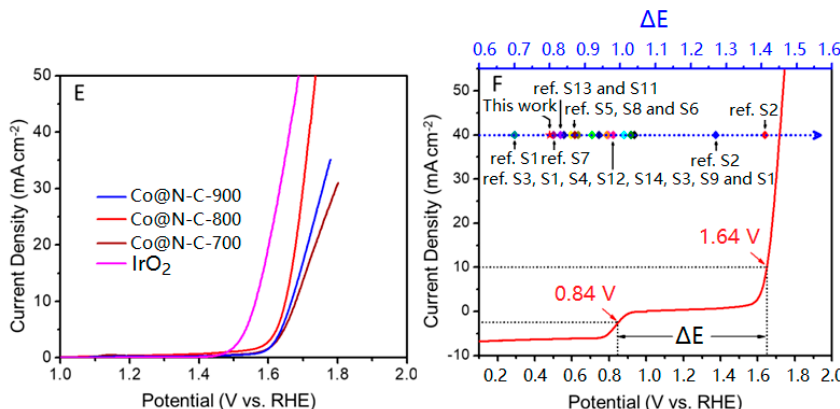
Figure 6. ORR and oxygen evolution reaction (OER) performances of Co@N ‐ C and Pt/C with the loading of 100 μ g cm − 2 using O 2 ‐ saturated 0.1 M KOH as electrolyte. ( A ) Static cyclic voltammogram (CV) curves of different catalysts (solid line: in O 2 ‐ saturated electrolyte; dotted line: in N 2 ‐ saturated electrolyte), ( B ) linear sweep voltammograms (LSV) plots of catalysts for ORR at 1600 rmp, ( C ) ORR polarization curves of Co@N ‐ C ‐ 800 at different rotating speeds (600 to 2000 rpm), ( D ) the K ‐ L plots of Co@N ‐ C ‐ 800 derived from rotating disk electrode (RDE) data and electron transfer number ( n ) per oxygen molecule (O 2 ) at potentials from 0.1 to 0.4 V, ( E ) LSV plots of catalysts for OER at 1600 rmp and ( F ) the bifunctional catalytic activities of Co@N ‐ C ‐ 800 within the ORR and OER potential window. Table 1. Catalytic activity data of various catalysts for oxygen reduction reaction (ORR). Onset Potential Cathodic Peak Potential Cathodic Peak Current Electrocatalyst (V vs. RHE) (V vs. RHE) Density (mA cm − 2 ) Pt/C